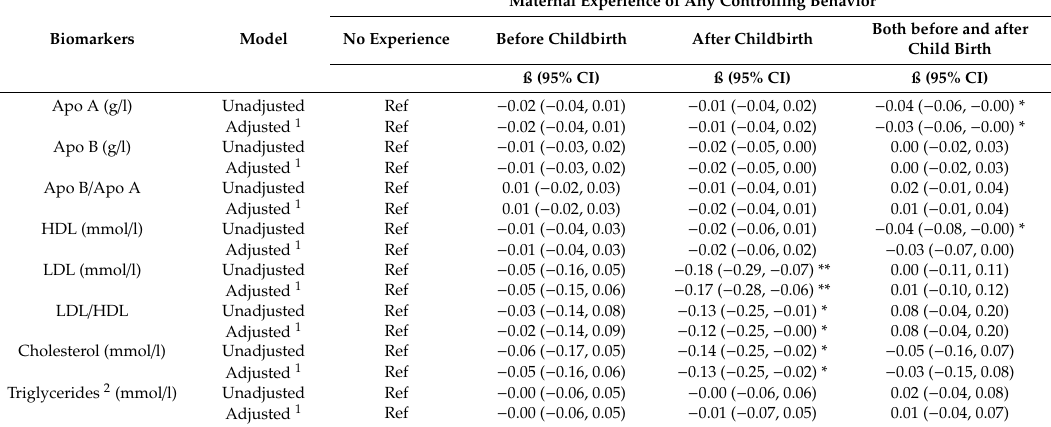
Table 5. Association of children’s level of lipid biomarkers with maternal experience of any controlling behavior before and after childbirth. Maternal Experience of Any Controlling Behavior Biomarkers Model No Experience Before Childbirth After Childbirth Both before and after Child Birth ß (95% CI) ß (95% CI) ß (95%